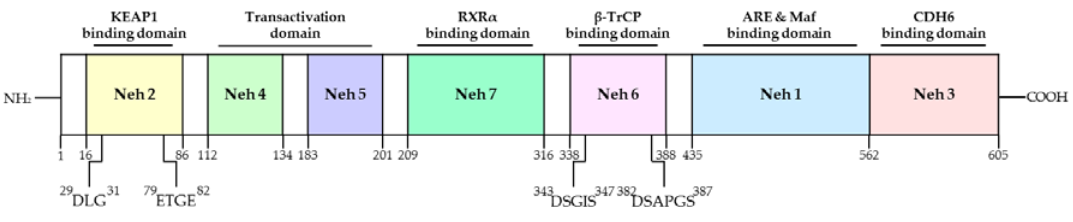
Figure 3. Domain structures and functional domains of Nrf2. The Nrf2 protein contains 7 domains, Neh1-7. The N-terminal Nrf2-ECH homology (Neh) 2 domain has ETGE and DLG motifs that bind to the Kelch domain of Kelch-like ECH-associated protein 1 (KEAP1), resulting in Cullin 3 (Cul3)-dependent E3 ubiquitination and proteasome degradation. The Neh4 and Neh5 domains mediate the transactivation activity of Nrf2. The Neh7 domain inhibits transcription of the Nrf2 target gene. The Neh6 domain has DSGIS and DSAPGS motif. The Neh1 domain helps Nrf2 dimerization with DNA binding to other transcription factors. The C-terminal Neh3 domain supports the Nrf2 transcriptional activity. Adapted from Ooi et al. [57]. NH 2 ; N-terminal, COOH; C-terminal, RXR α ; retinoed X receptor-alpha, β -TrCP; beta-transducin repeat containing E3 ubiquitin protein ligase, ARE; antioxidant response element, CDH6; chromo-ATPase/helicase DNA-binding protein 6.